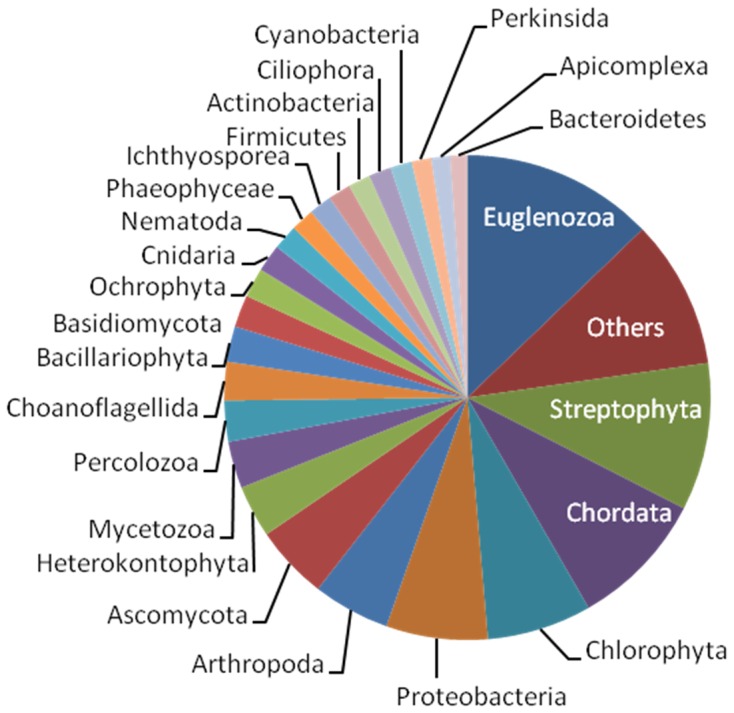
Taxonomic (phylum) distribution of top sequence hits.Phyla that accounted for less than 1% of the unique sequences were pooled as “Others”.